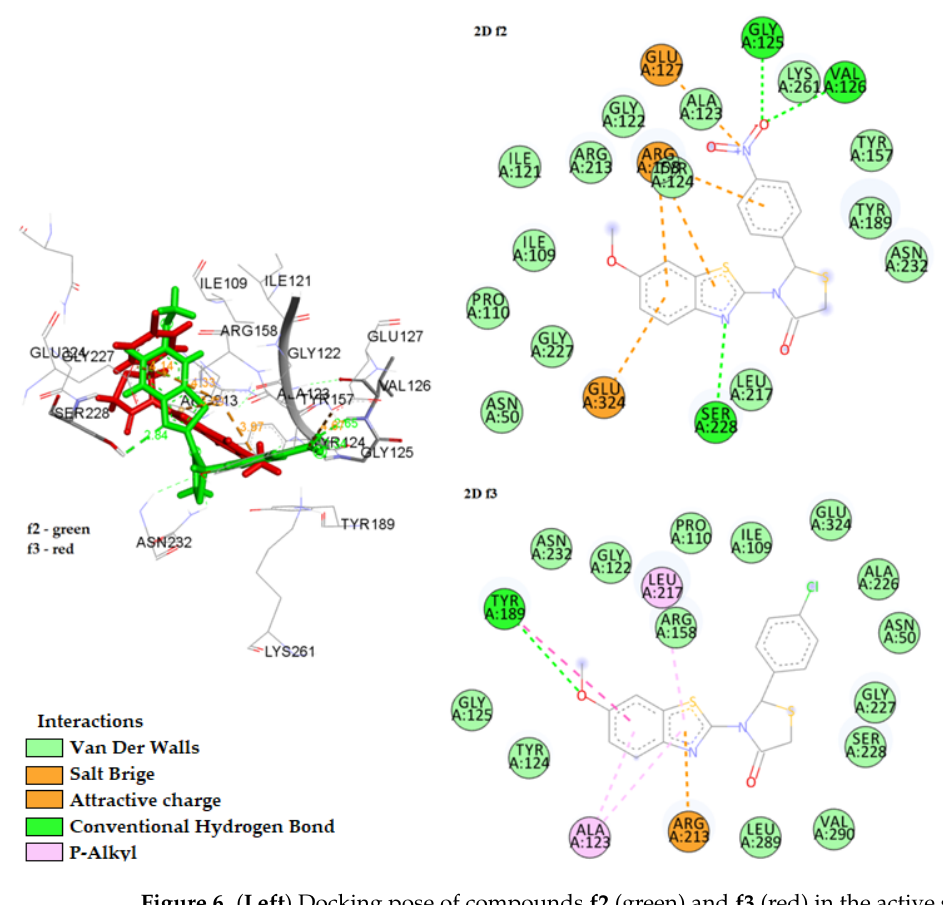
Figure 6. ( Left ) Docking pose of compounds f2 (green) and f3 (red) in the active site of the enzyme. ( Right ) 2D diagram of compounds 8 and 9 . The hydrogen bond is represented by a dotted green line. Table 6. Results of docking studies of compounds 5 , 8, and 15 (R-isomers) to the enzymes MurB Pseudomonas aeruginosa, P.a., (4JAY); Listeria monocytogenes, L.m., (3TX1); and Staphylococcus